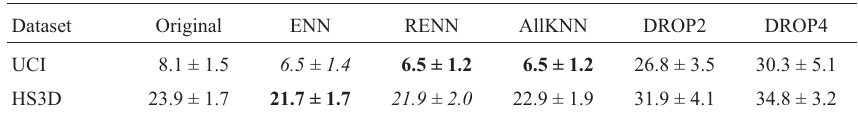
Table 7 - DT test error